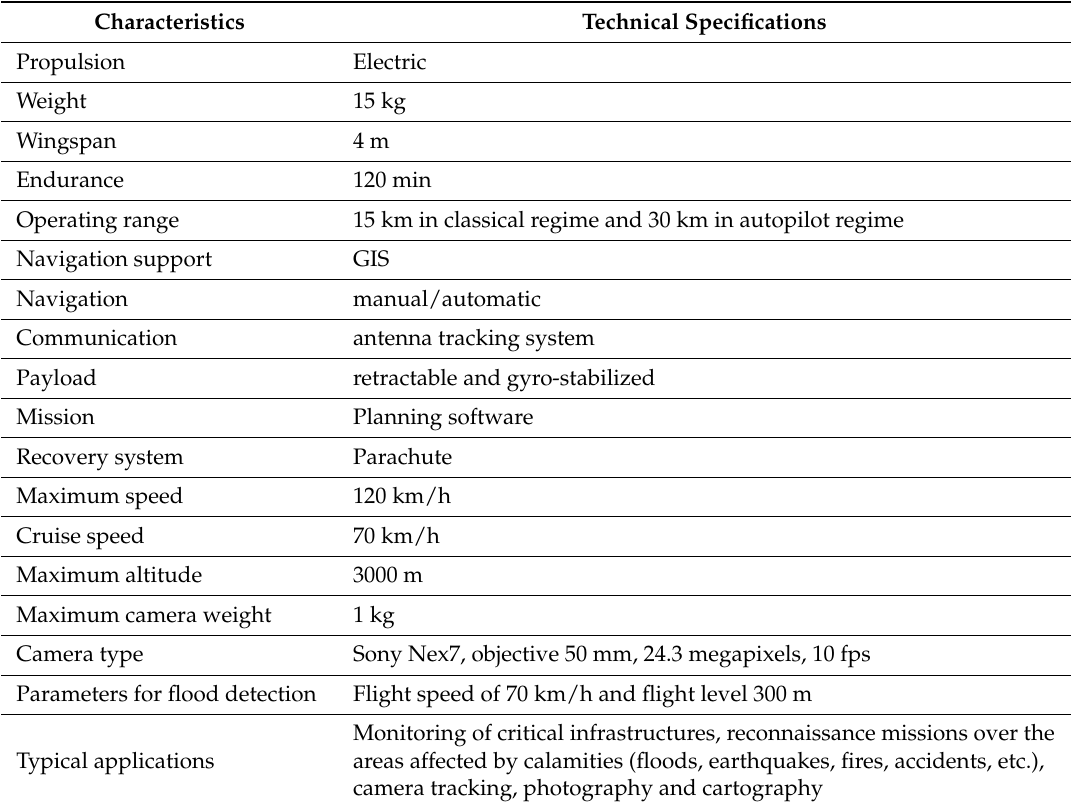
Table 3. MUROS UAV—Characteristics and technical specifications.